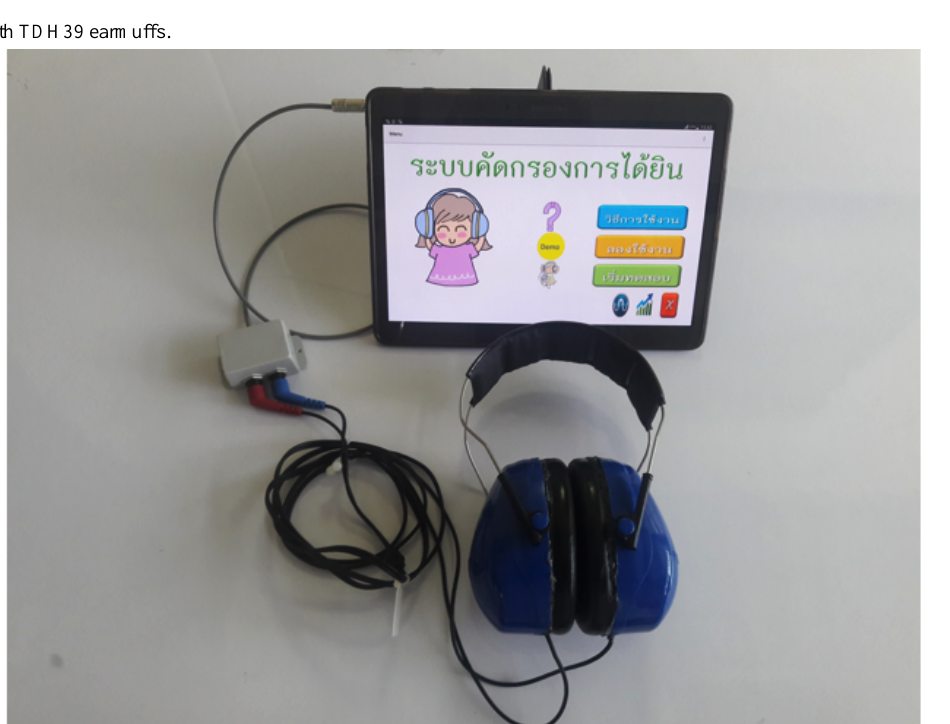
Figure 5. Tablet with TDH39